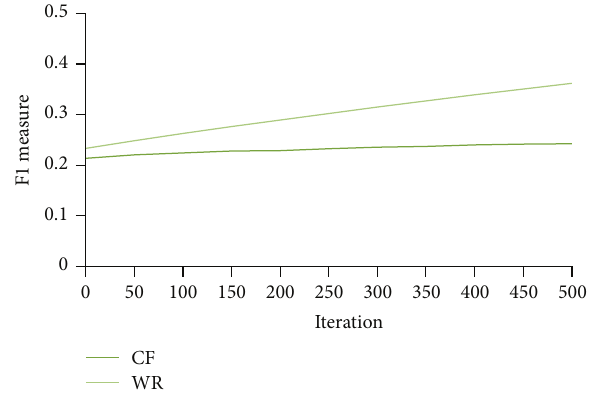
Figure 11: WebBluegillRecom-annealing system (WR) is compared to standard collaborative filtering (CF) system on 𝐹1 measure, 𝐼 = 5 , 248 users.